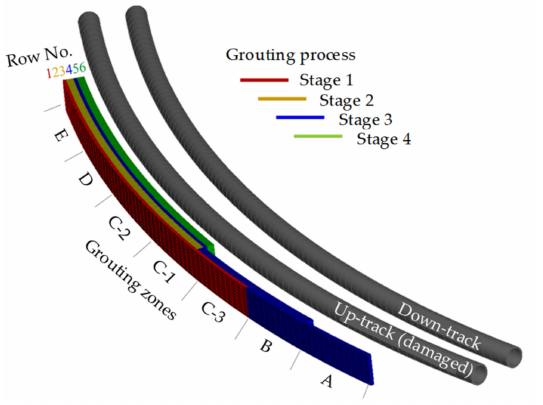
Figure 5. Stages of the grouting